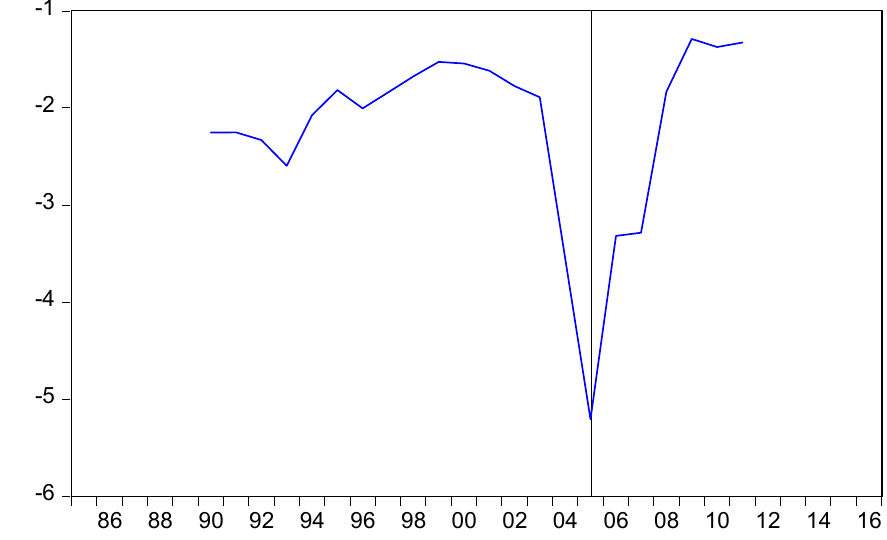
Figure 6. Zivot-Andrew breakpoints test results.